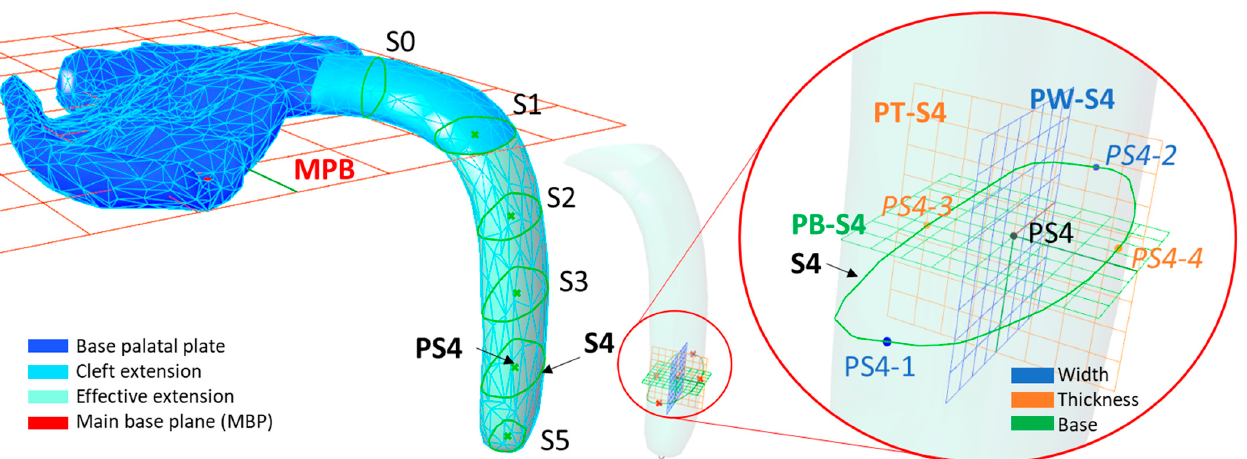
Figure 9. Isometric view of the measured part, with the sectional curves along the curve. S 0 is the only section of the cleft extension, as this is the section with the lowest area. S 1 –S 5 are distributed along the effective extension proportionally.